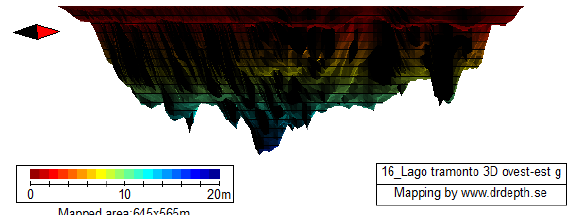
Figure 7. Gambulaga – Portomaggiore (FE), Tramonto Lake. 3D Section West-East (G. Zuffi).